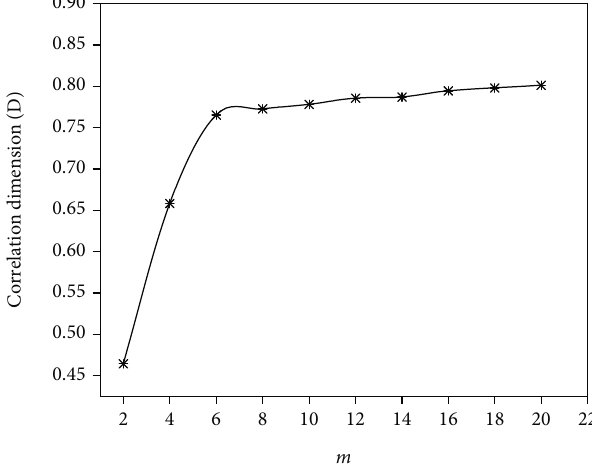
Figure 12: The relationship between correlation dimension D and parameter m